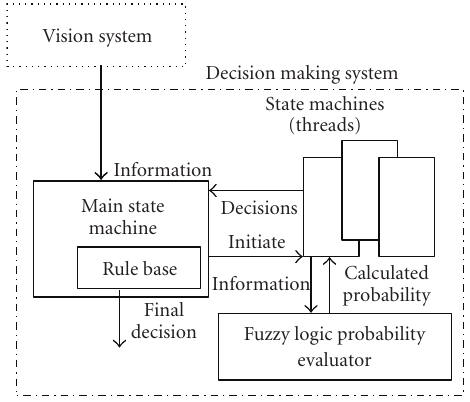
Figure 4: The Robot soccer game event referee system